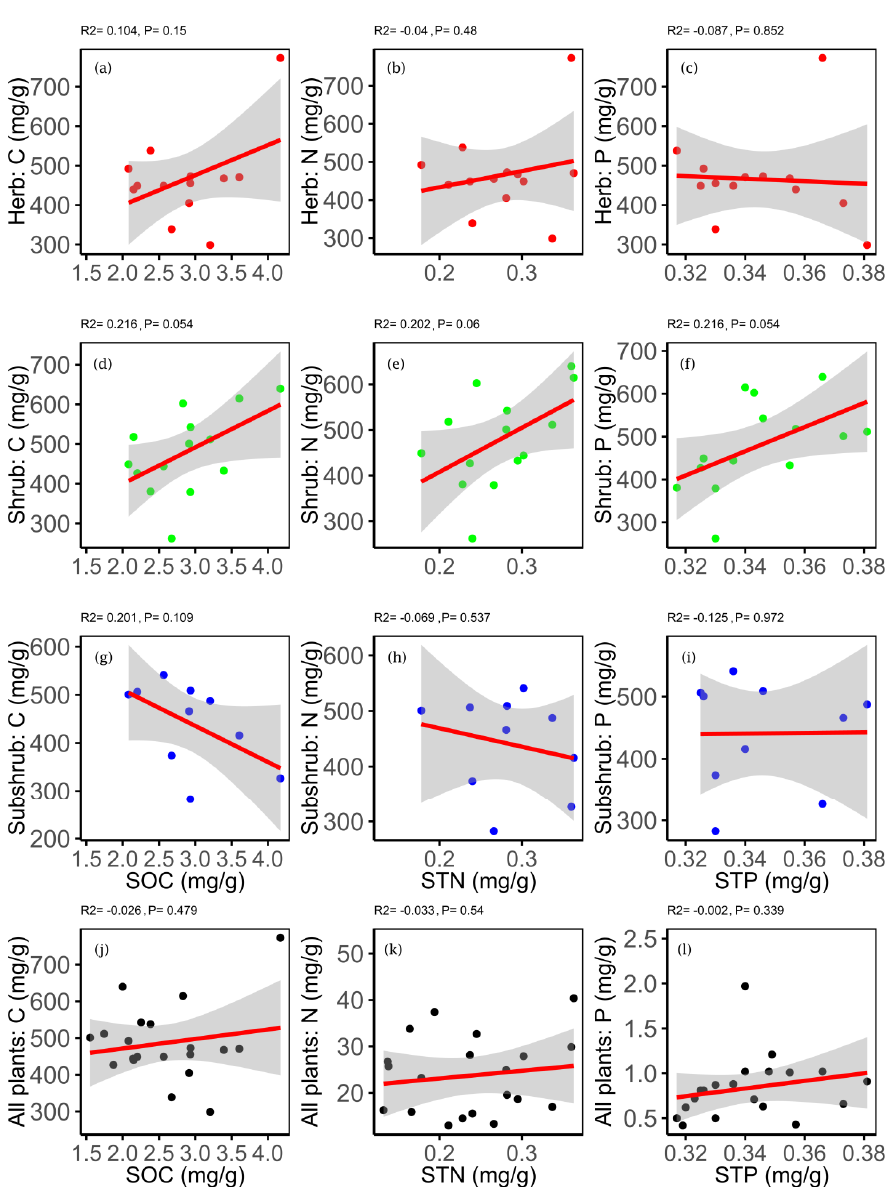
Figure 5. Relationship between leaf carbon (C) and soil organic carbon (SOC) (in panel a , d , g ); leaf nitrogen (N) and soil total nitrogen (STN) (in panel b , e , h ); and leaf phosphorus (P) and soil total phosphorus (STP) (in panel c , f , i ). Red dots used for herb (in panel a , b , c ), green for shrub (in panel d , e , f ), blue for subshrub (in panel g , h , i ) and black for all plants (in panel j , k , l ).